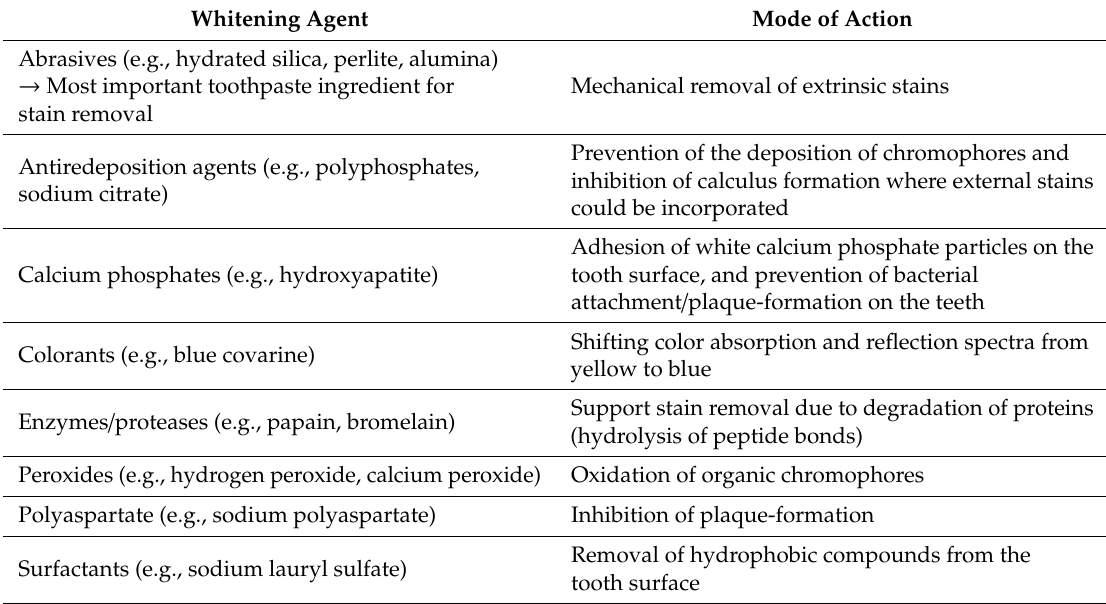
Table 1. Examples of commonly used whitening agents in products for home and professional use